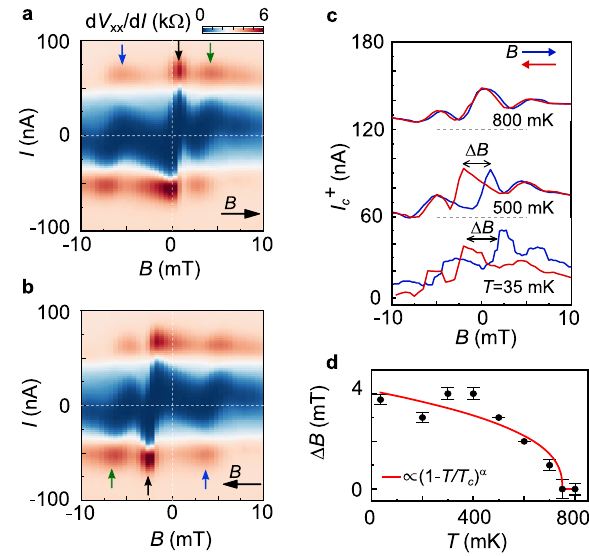
Fig. 4 | Evolution of magnetic hysteresis with temperature. a , b Fraunhofer patterns measured at 500mK with fi eld sweeping up ( a ) and down ( b ) as marked with the black arrows. The white dashed lines mark the 0 current and 0 fi eld positions.The colored arrows highlightaperiod change in the patternand the fact thatbyrotating a by180°onewouldgettheperiodicityof b . c I c + extractedfromthe Fraunhofer patterns with the magnetic fi eld sweeping up (blue) and down (red) at 800, 500, and 35mK. The curves are vertically shifted by 60nA each for clarity. d Extracted Δ B vs. temperature T for I c + . The red curve is a fi t to the Curie – Bloch equation (1 – T / T c ) α with fi tting parameters T c ~750±25mK and α ~0.4±0.05. The error bars are de fi ned as the standard deviation of the extracted I c values as explained in the